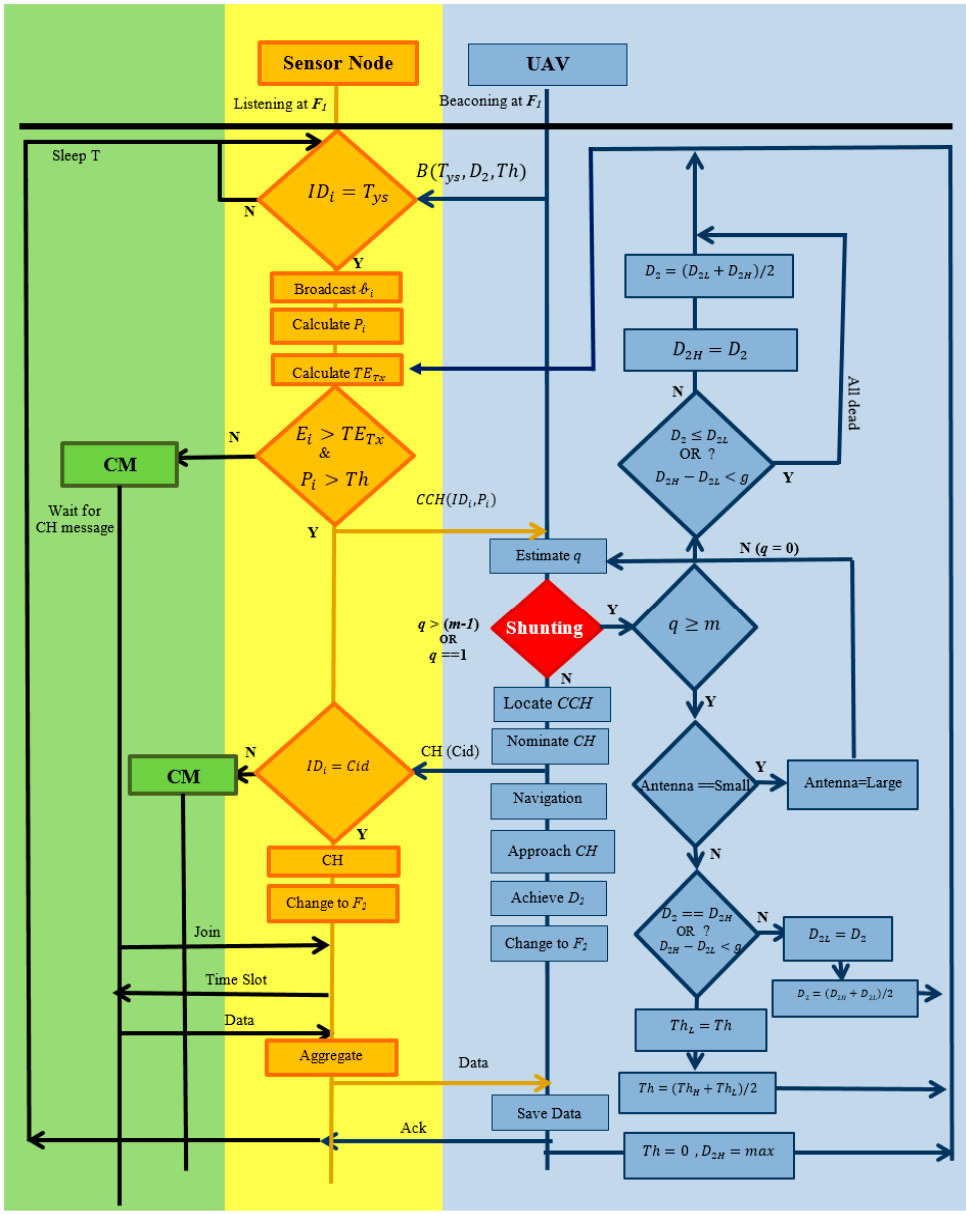
Figure 8. State diagram of the developed system.